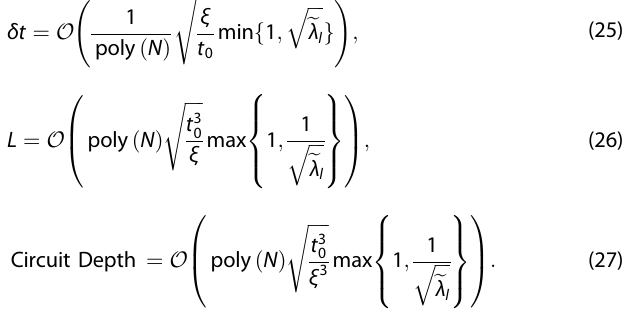
As a comparison, in general case with j e E l (cid:3) E l j ¼ Oð poly ð N Þ δ t Þ , the fi nal circuit depth is Oð poly ð N Þ t 2